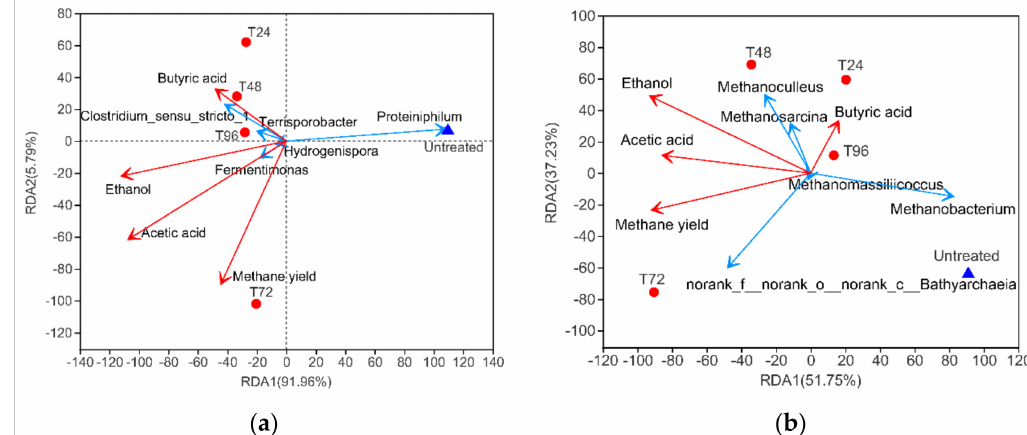
Figure 8. Redundancy analysis (RDA) analysis of: ( a ) bacterial communities at Genus level; ( b ) archaeal communities at Genus level. Red arrows represent environmental factors; blue arrows represent species; scattered dots represent experiment